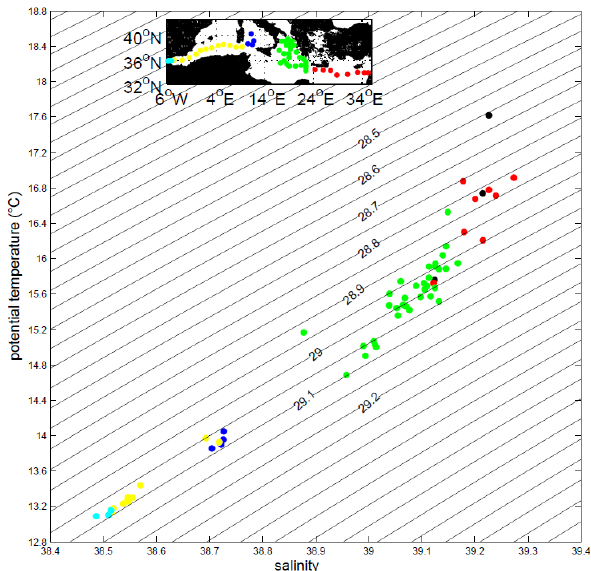
Figure 3. T – S diagram of maximum salinity and corresponding temperature in the layer 50–650m, which shows the LIW core in the Mediterranean Sea. Colours show different regions. Black dots: Aegean Sea, red dots: Levantine Sea, green dots: Ionian Sea, blue dots: Tyrrhenian Sea, yellow dots: remaining western Mediter- ranean Sea, cyan dots: Strait of Gibraltar. Isolines for potential den- sity σ 0 = ρ 0 (referenced to sea surface) − 1000kgm − 3 (black con- tinuous line) are given. Inset panel shows the location of the differ- ent